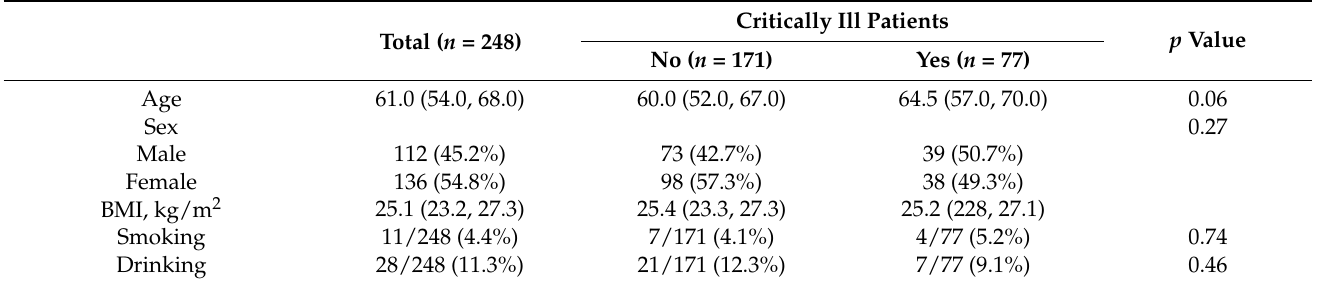
Table 1. Baseline characteristics according to disease